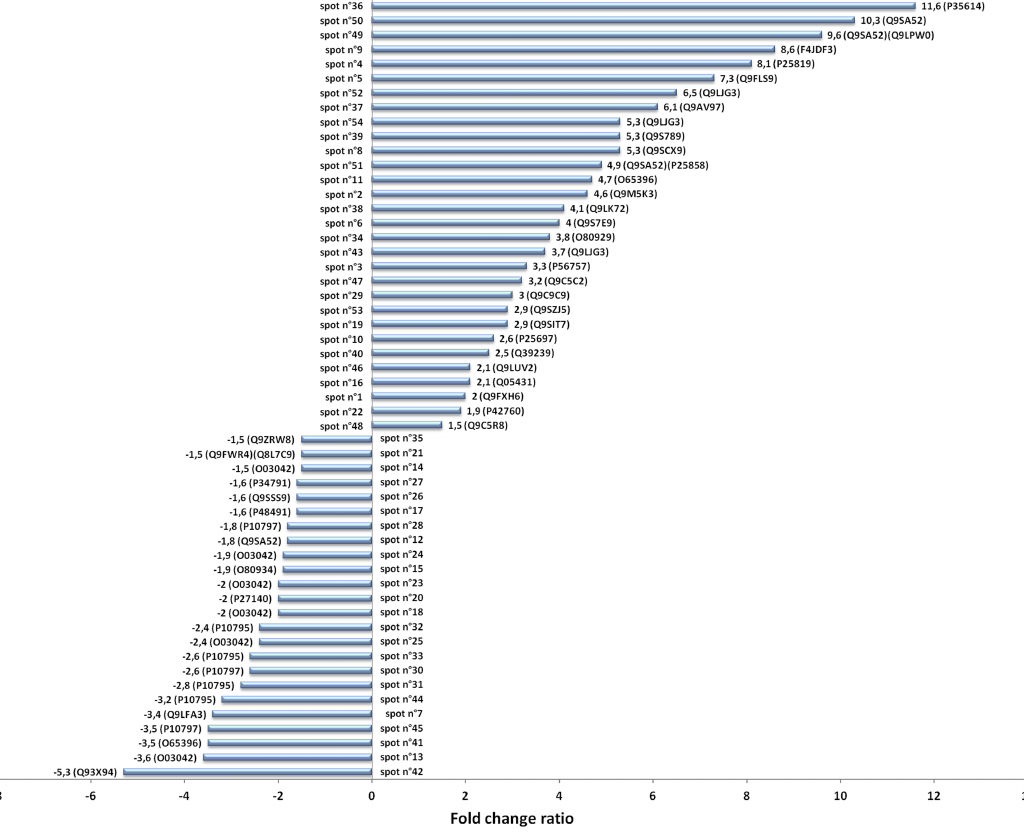
Figure 2. Level of expression of the identified spots. Data are negative when referred to the down-expressed proteins, while positive when referred to the over-expressed proteins. Numbers near the bar represents the fold ratio and the accession number (Uniprot databank). Bars represent the standard deviation of three replicates. Identification of each spot is provided in Tables 1 and